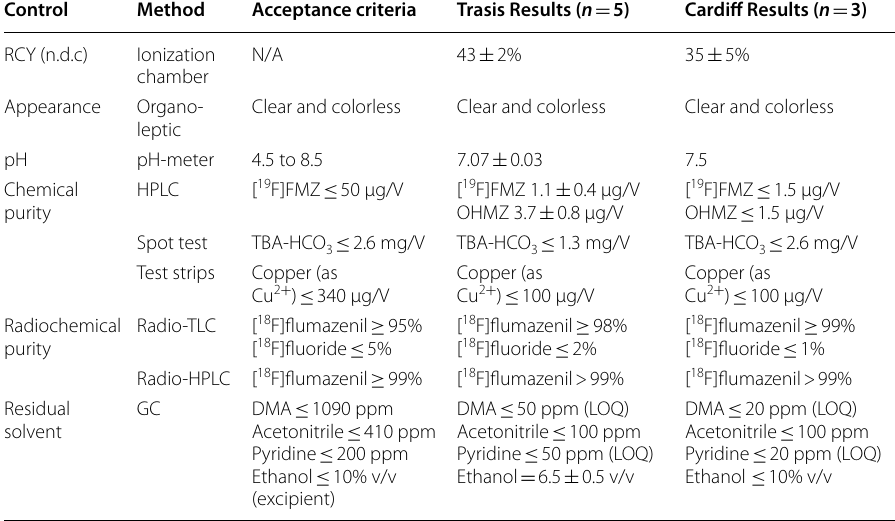
Table 1 Acceptance criteria and analytical data Control RCY